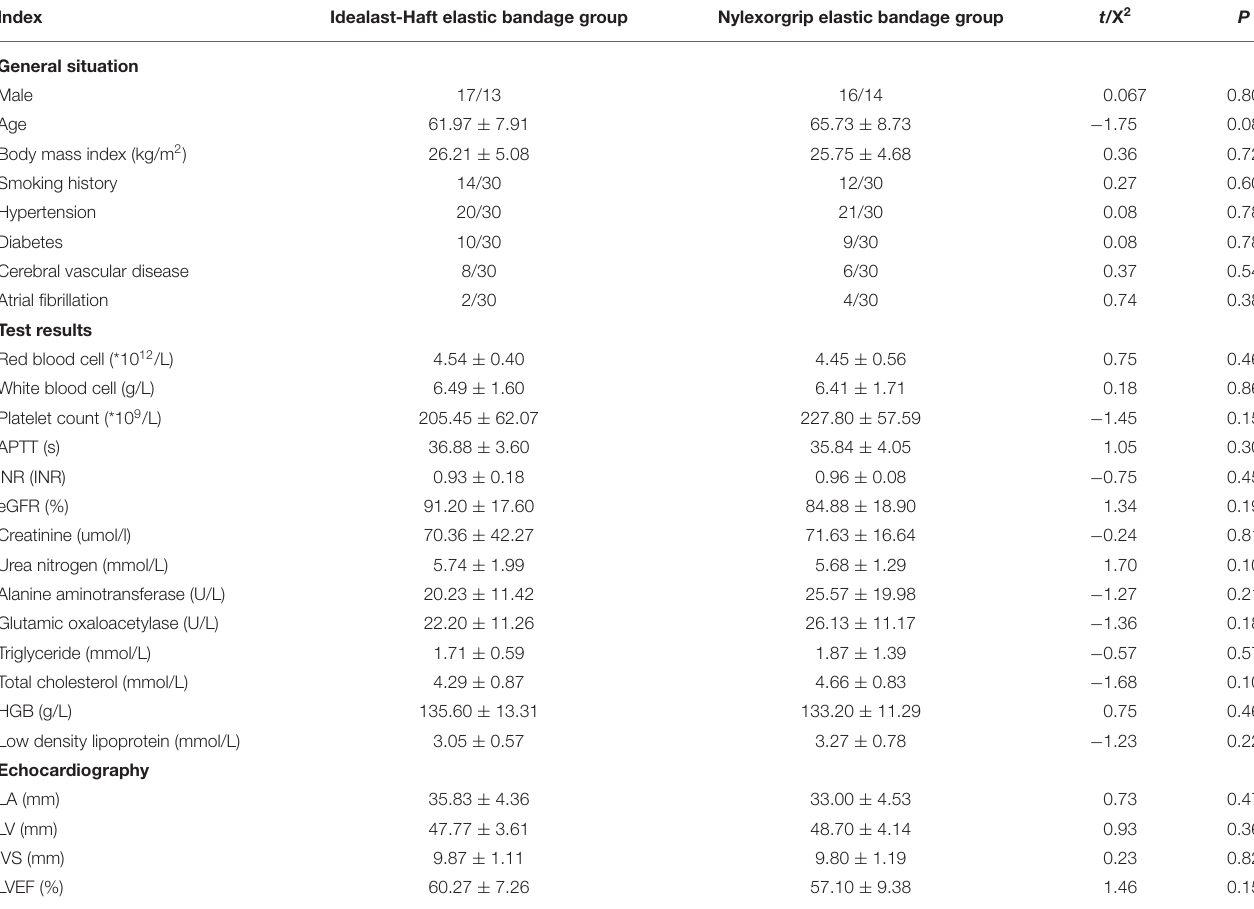
TABLE 2 | Comparison of clinical baseline characteristics and laboratory test results between the two